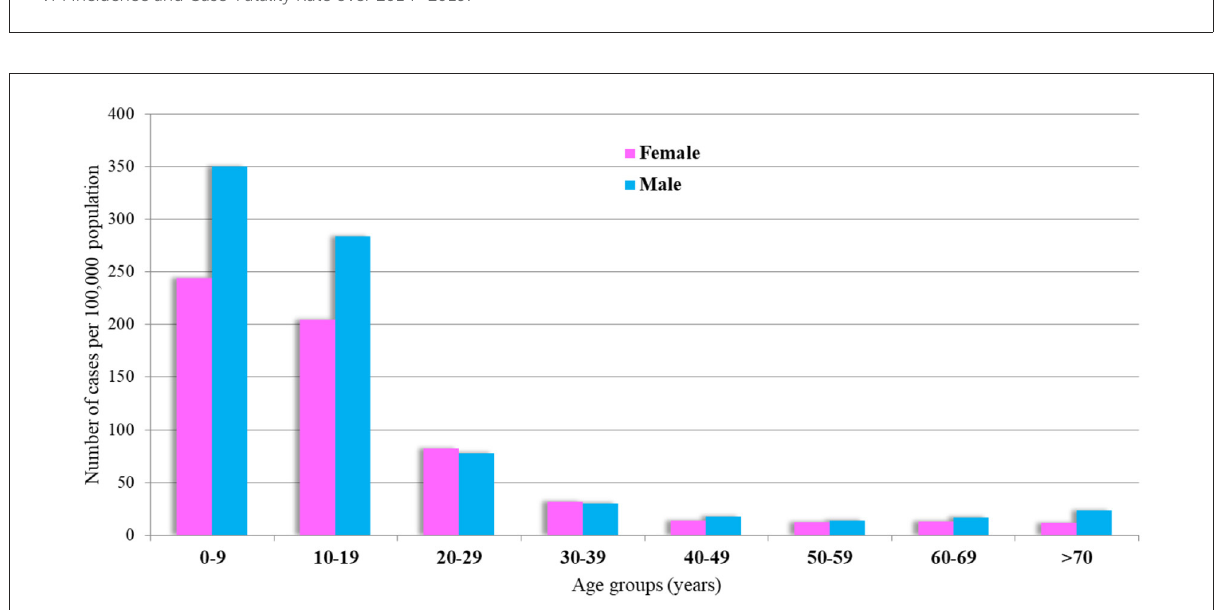
FIGURE4 Age and gender-specific incidence rates of VM over 2014–2019.